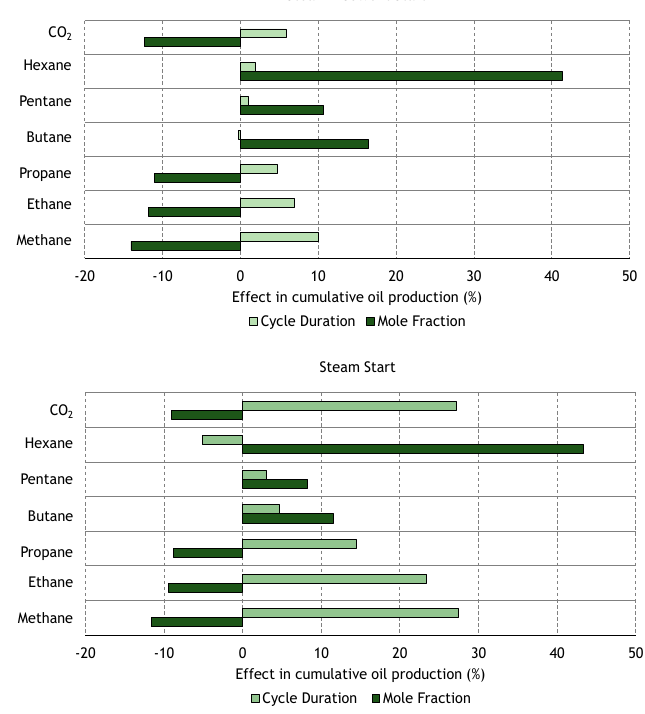
Figure 10. Pareto plot that shows the impact of the cycle duration and mole fraction changes on the cumulative oil production for di ff erent solvents and di ff erent start cumulative oil production for different solvents and different start modes.